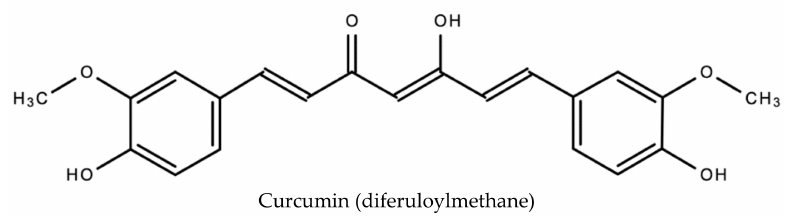
Figure 10. Chemical structure of curcumin (diferuloylmethane) found in Curcuma Longa L.